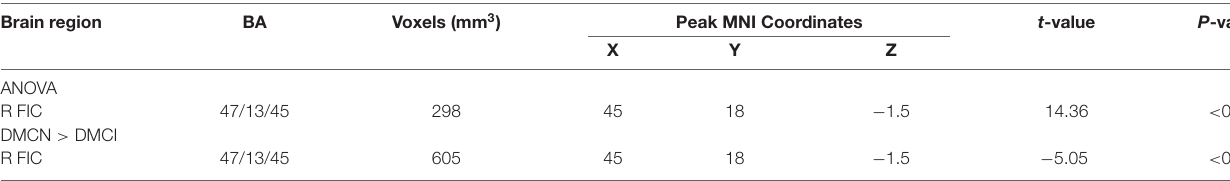
TABLE 3 | Demographic, clinical, and neuropsychological test results.